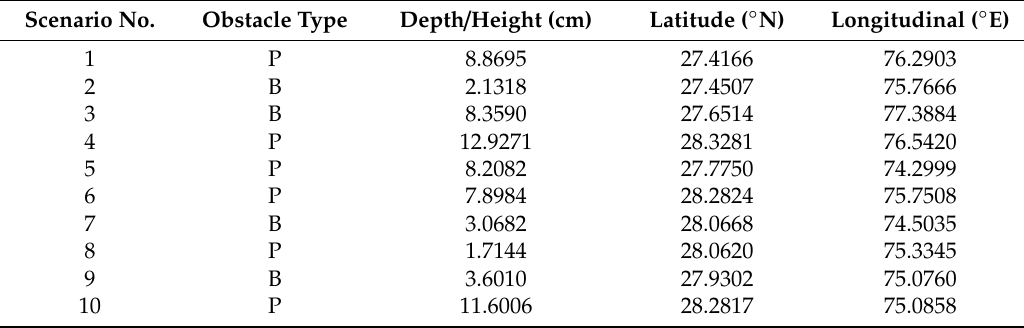
Table 6. Information of pothole (P) and bumps (B) collected during real-time testing using the image processing method for the R2 test site.